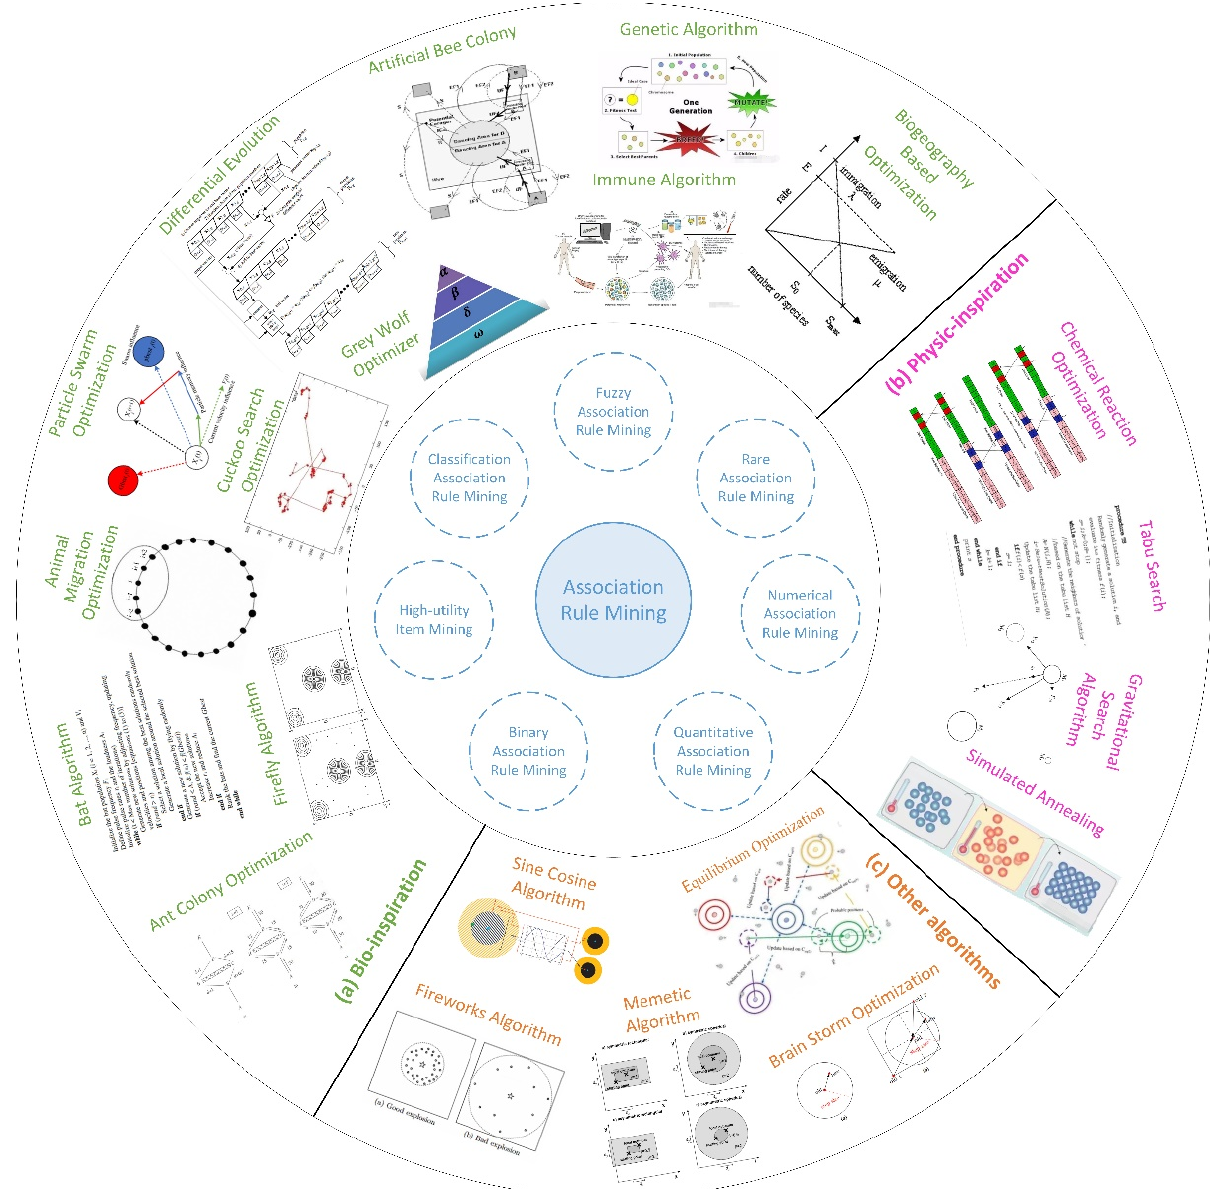
Figure 1. The research process of